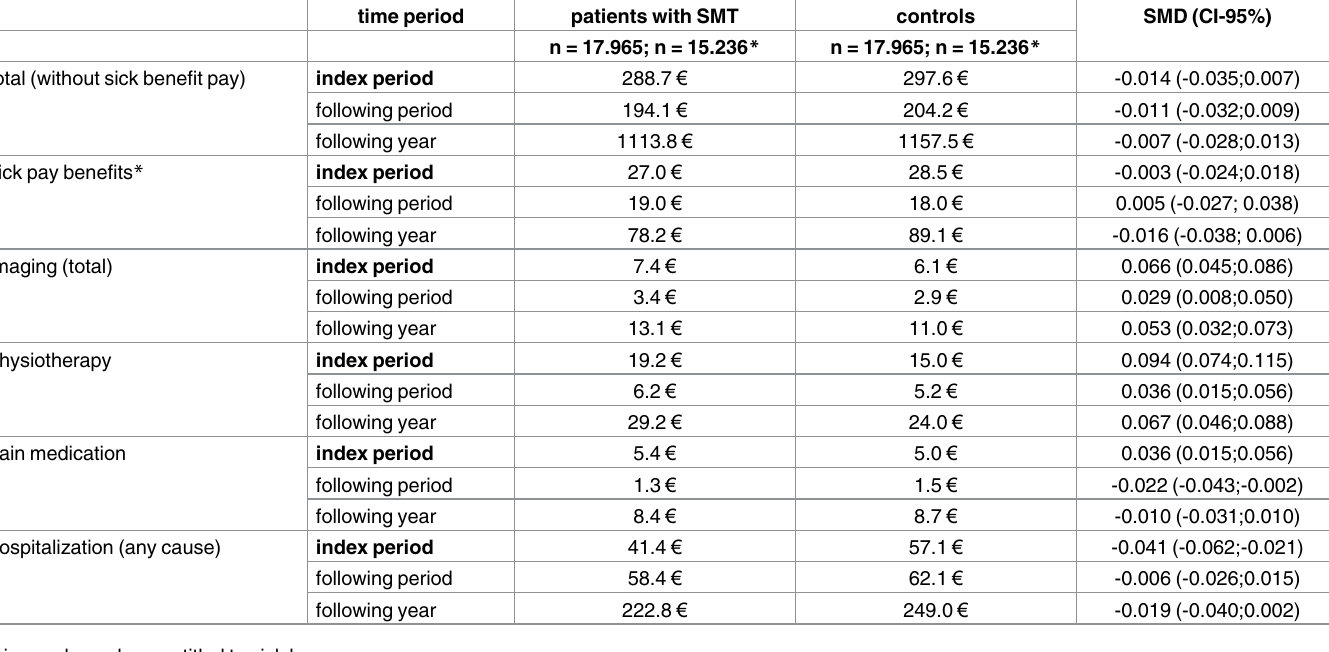
Table 4. Averagecosts for health